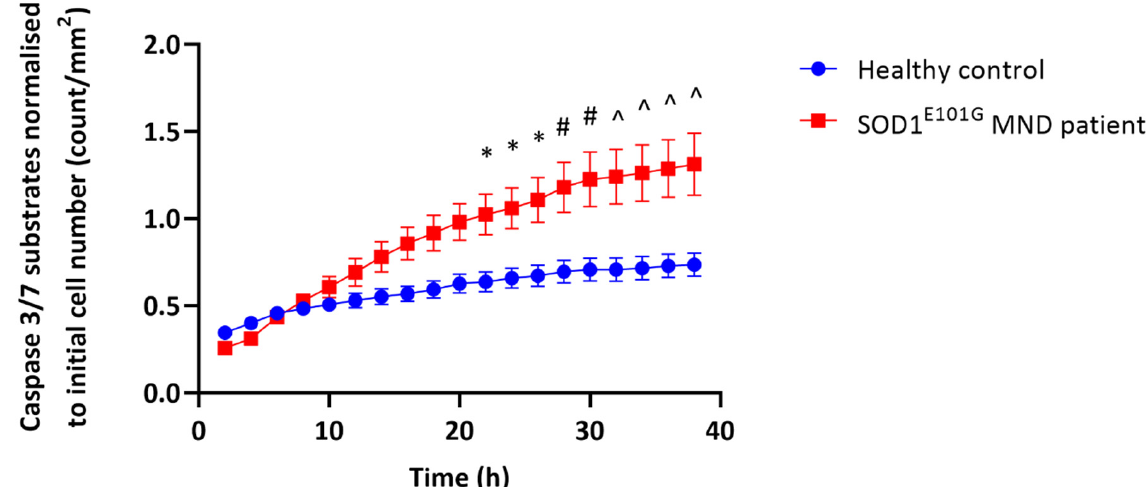
Figure 2. IPSC-derived motor neurons from a SOD1 E101G MND patient are more vulnerable to oxidative stress then iPSC-derived motor neurons from a healthy control. IPSC-derived motor neurons from a SOD1 E101G MND patient and a healthy control were matured for three weeks under hypoxic conditions (3% oxygen) and then transferred to a normoxic incubator (21% oxygen) for 38 h in order to induce oxidative stress. Apoptosis was assessed by quantifying the number of caspase 3/7 substrates every 2 h using an Incucyte. Two-way ANOVA revealed that there were significant main effects of time (F(18,144) = 36.53, p < 0.0001), cell line (F(1.8) = 8.677, p = 0.0185), and time × cell line interaction (F(18.112) = 8.830, p < 0.0001). Sidak’s test for multiple comparisons showed that iPSC-derived motor neurons from the SOD1 E101G MND patient showed a significant increase in the number of caspase 3/7 substrates per mm 2 from 22 h onwards compared to the healthy control. Data presented as mean ± SEM of n = 5 technical replicates; * p < 0.05; # p < 0.01; ˆ p <